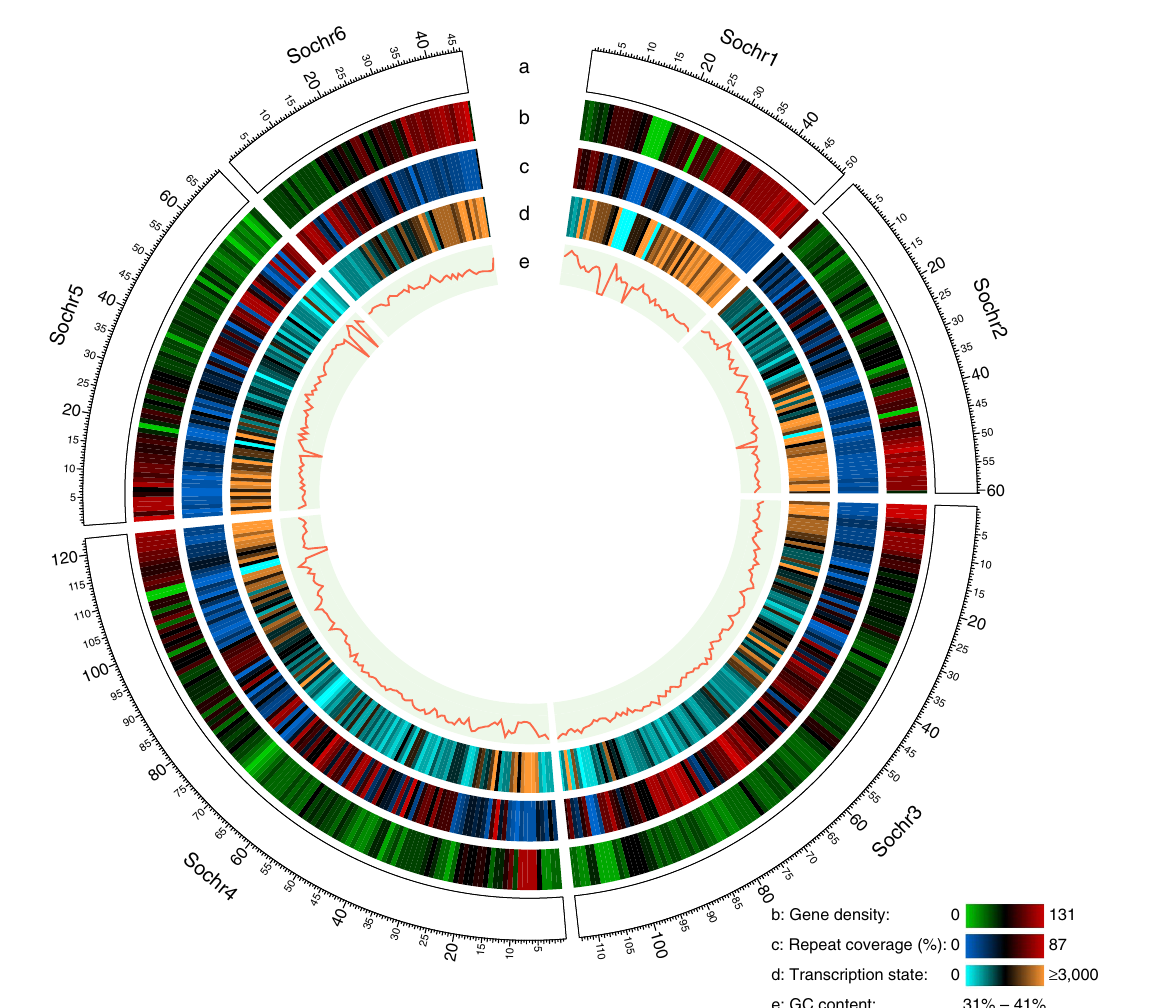
Figure 1 | Spinach genome landscape. ( a ) Ideogram of the six spinach pseudochromosomes (in Mb scale). ( b ) Gene density represented as number of genes per Mb. ( c ) Percentage of coverage of repeat sequences per Mb. ( d ) Transcription state. The transcription level was estimated by read counts per million mapped reads in 1-Mb windows. ( e ) GC content in 1-Mb windows. The six spinach pseudo-chromosomes represented 47% of the genome assembly. This figure was generated using Circos (http://circos.ca/).